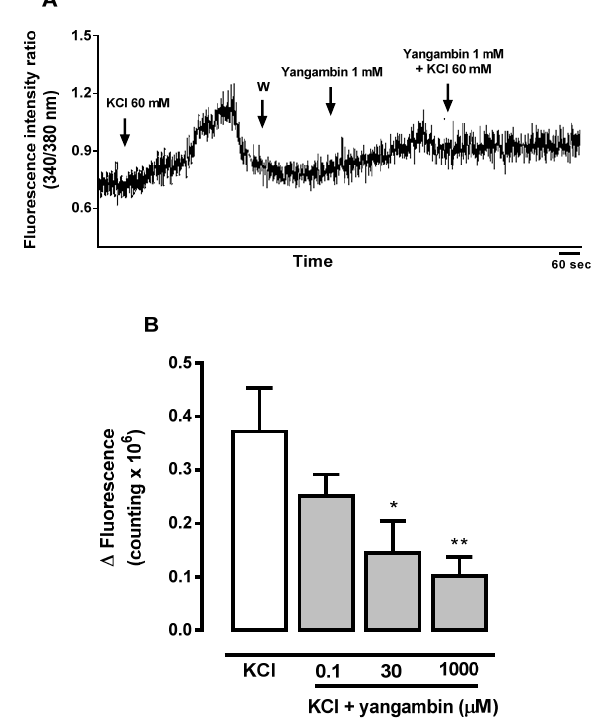
Figure 6. ( A ) Representative tracing showing the inhibitory effect of yangambin on the Ca 2+ signal evoked by KCl 60 mM in fura-2/AM-loaded mesenteric smooth muscle cell. ( B ) Bar graph showing the inhibitory effect of yangambin on the Ca 2+ signal evoked by KCl 60 mM. Results are expressed as mean ± S.E.M. ( n = 3). * p < 0.05 vs. KCl, ** p < 0.01 vs.